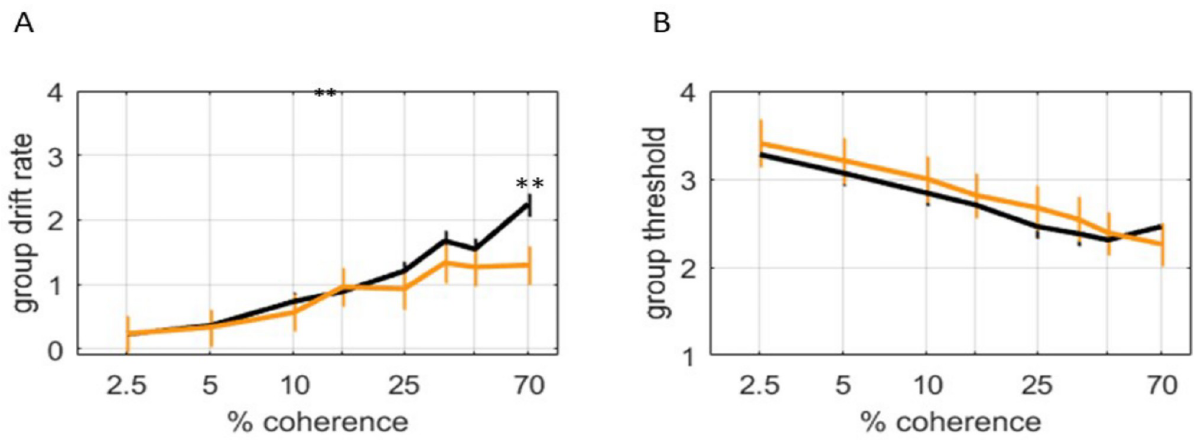
Fig 4. Behavioral task performance in participants with high ( > 60) and low ( � 60) doubt scores. A) A posterior distribution of group mean drift rate was calculated using HDDM, and indicates the rate of evidence accumulation over 8 different coherences. The most likely group means are plotted; error bars indicate the posterior standard deviation. With higher coherence, higher drift rates were observed for both high doubt (orange color, N = 10) and low (black color, N = 36) subjects. However, at higher levels of coherence, high doubt subjects exhibited even faster drift rates and reaction times than low doubt subjects (q < 0.01 for 70% coherence). B) No significant differences in the posterior distribution of HDDM threshold were observed between high and low doubt